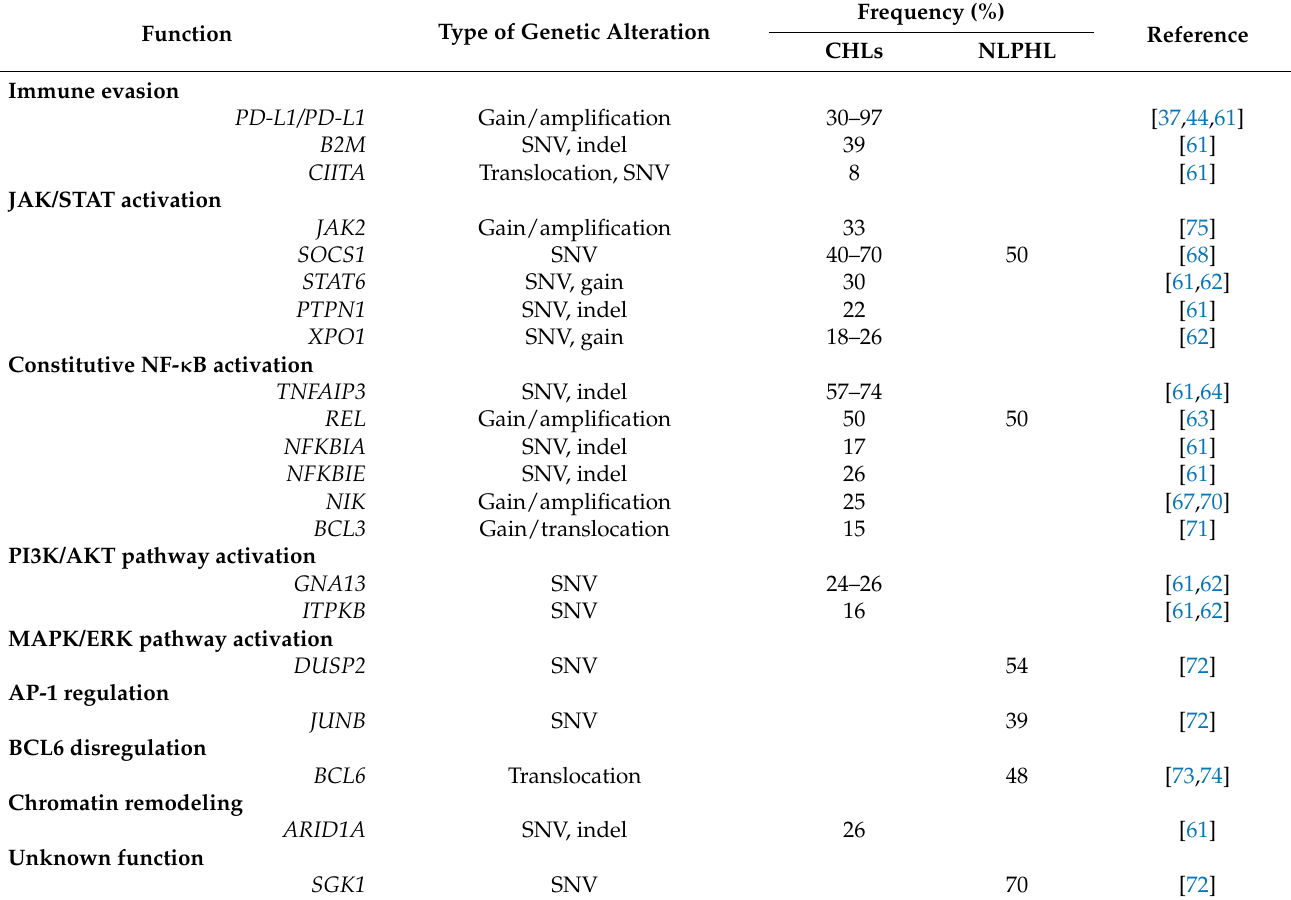
Table 1. Representative genetic alterations of classic Hodgkin lymphomas and nodular